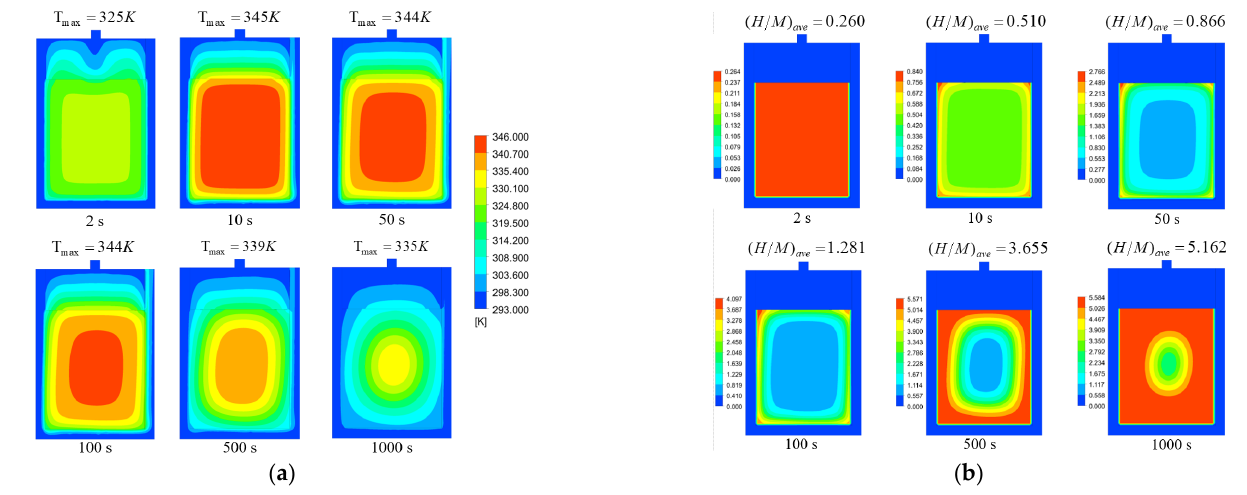
Figure 6. Temperature and hydrogen storage capacity distribution at different times of the reaction tank subjected to a cooling water flow rate of 0.01 m/s. ( a ) Temperature distribution cloud chart; ( b ) Hydrogen storage capacity distribution cloud chart.